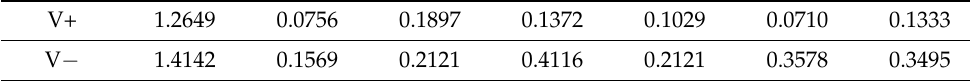
Table 8. Positive ideal and negative ideal